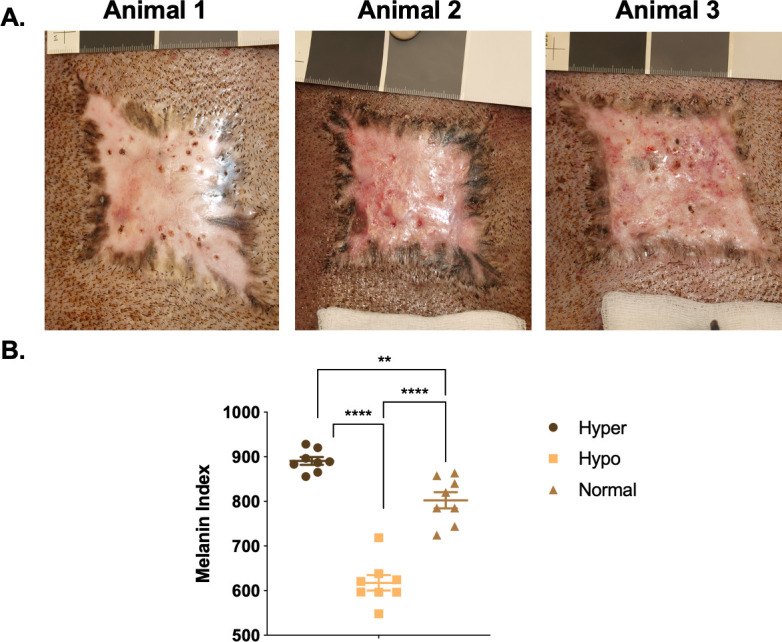
Heterogeneous dyschromia with hyper- and hypo-pigmentation develops after full thickness excision wounding in porcine HTS.Examples of HTS from 3 pigs (A). SCC non-invasive skin probe was used to measure melanin in the different pigmentation phenotypes (B) (mean ± SEM, n = 8 scars). **p<0.01, ****p<0.0001.